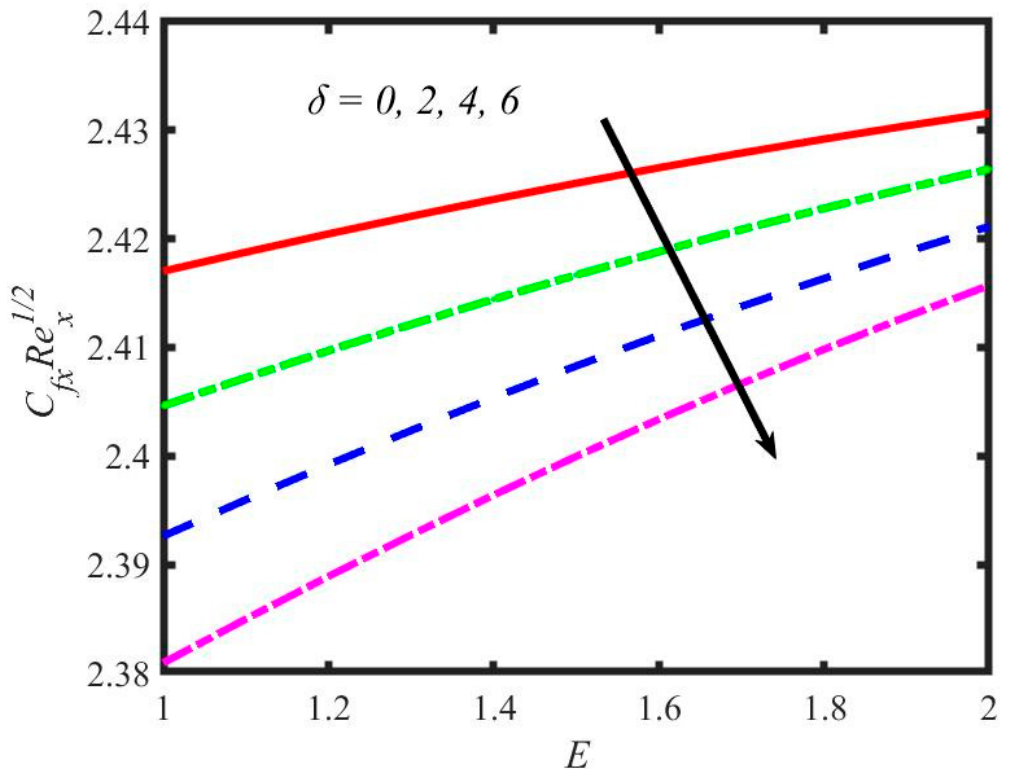
Figure 29. Variations in skin friction coefficient for microorganisms’ parameter.